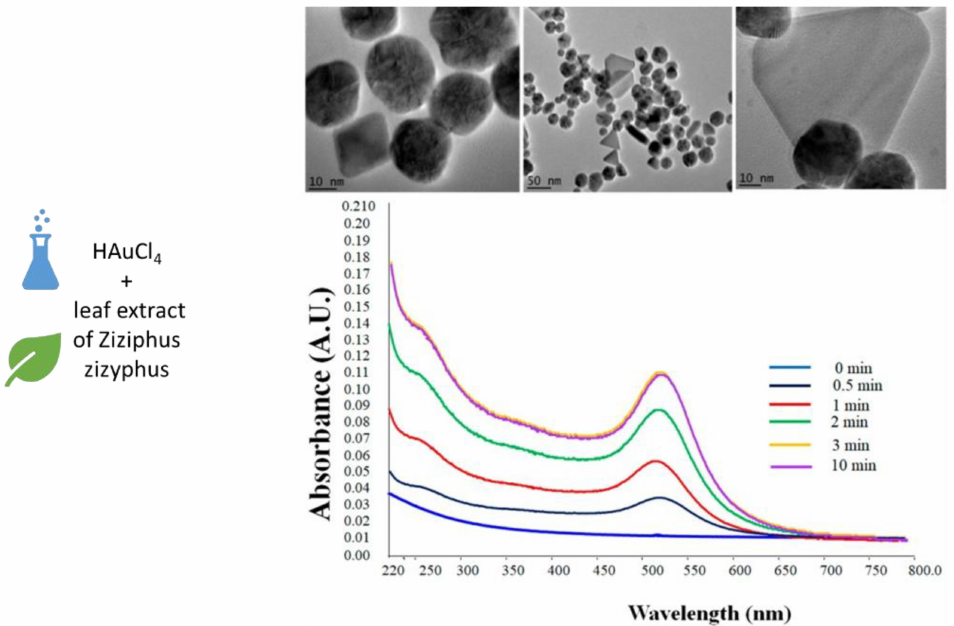
Figure 4. Gold nanoparticles production using leaf extract of Ziziphus zizyphus : UV-Vis and TEM analysis. Adapted with permission (Creative Commons CC BY license) from